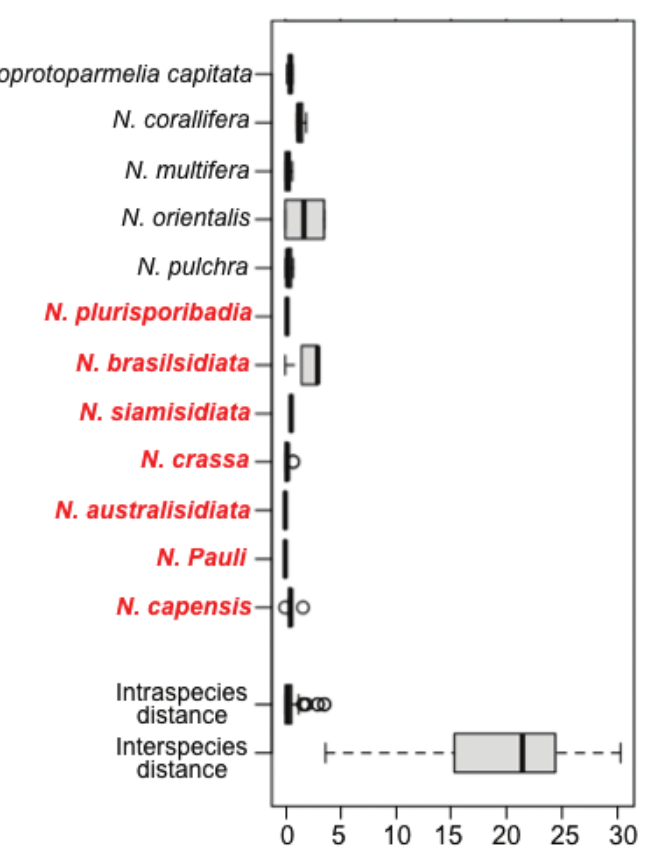
Figure 2. Boxplot showing the intra- and interspecific genetic distances of Neoprotoparmelia species and the overall intraspecific distances from all species and pairwise interspecific distances. New species described in this study are marked in